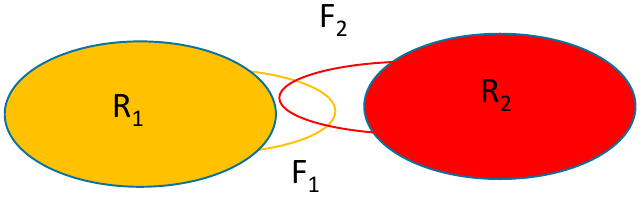
Figure 1. Schematics of the system considered. R 1 , R 2 : rigid part of macromolecules 1 and 2, respectively; F 1 , F 2 : flexible part of macromolecules 1 and 2, respectively .